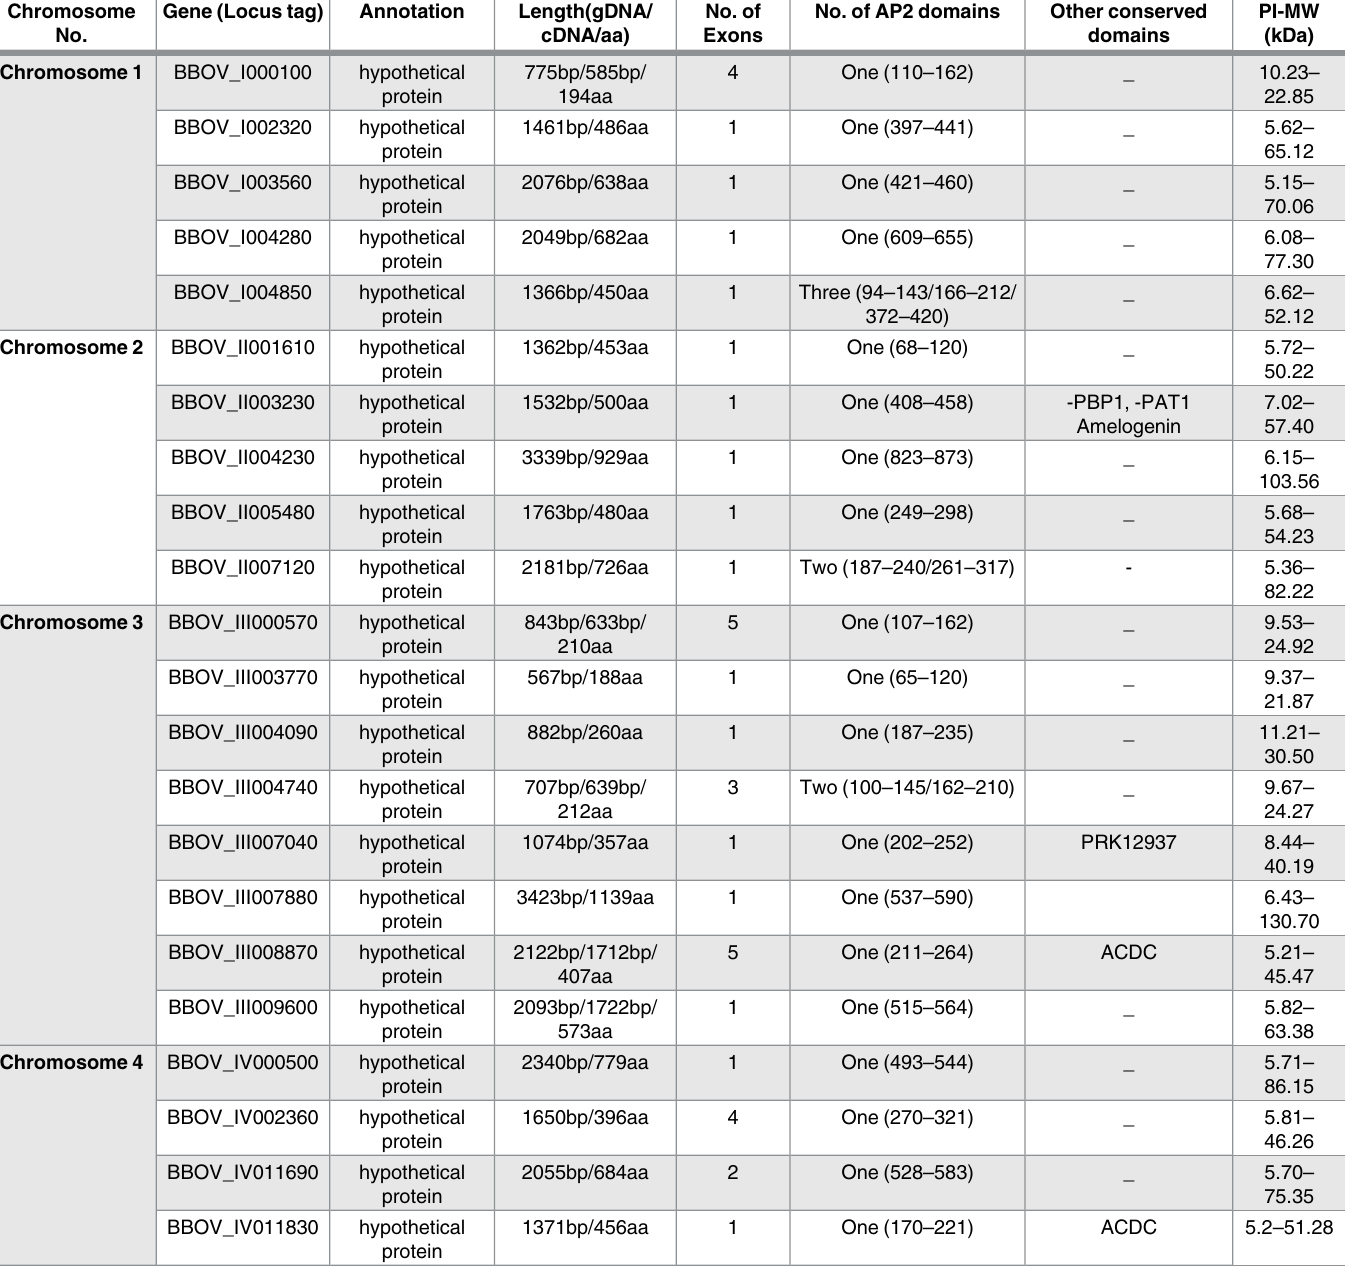
Table 1. Characteristics of AP2 genes identified in the B . bovis